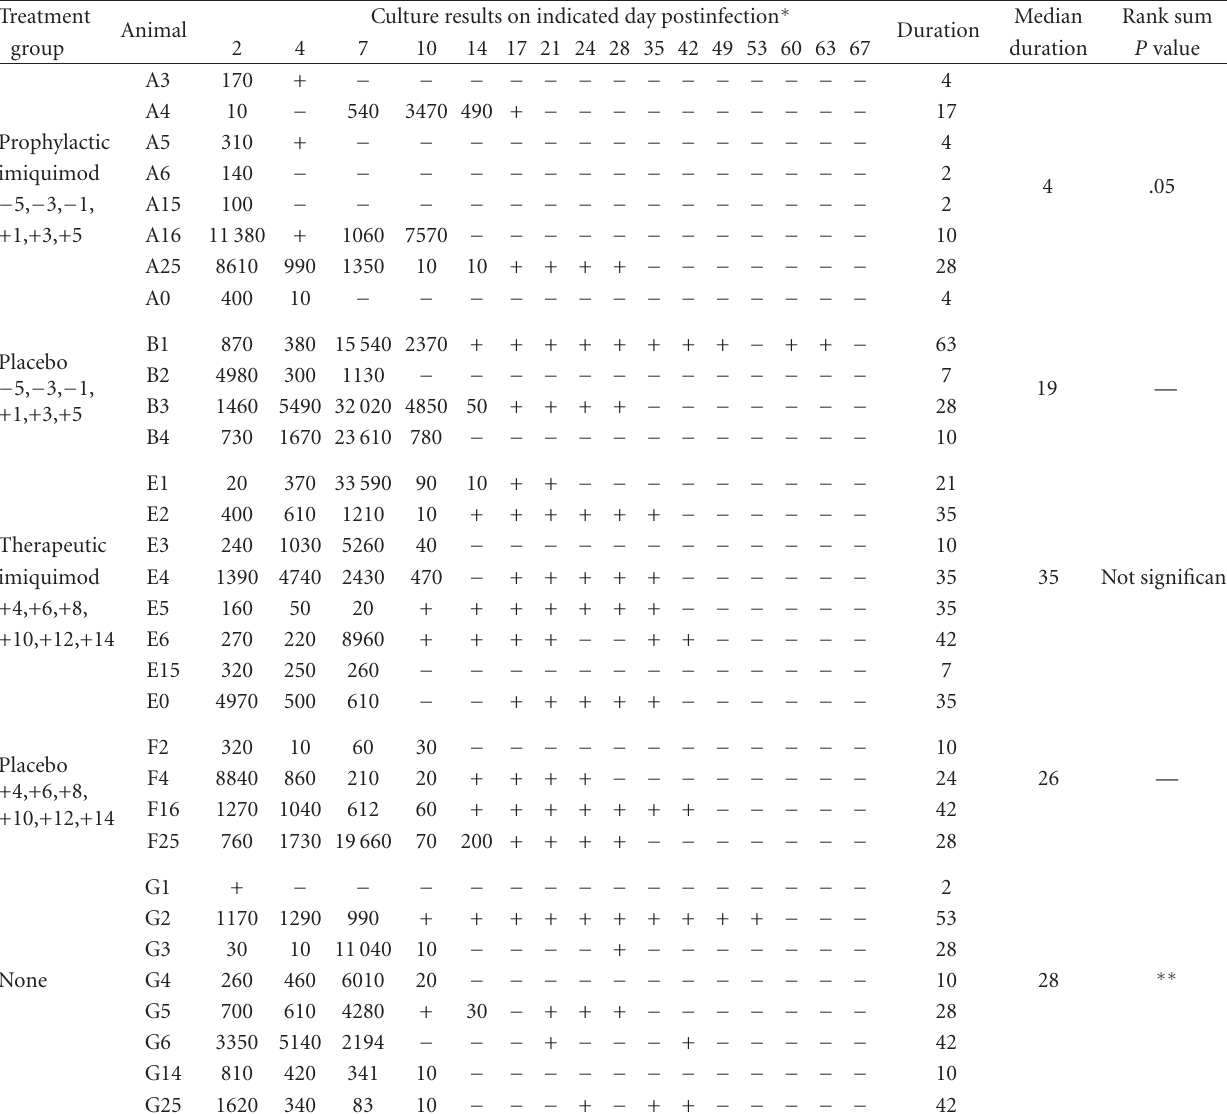
∗ Mice were sampled every 2–7 days postinfection. Numerical values represent the number of IFU enumerated in primary culture through day 14; + / − represents the presence (+) or absence ( − ) of inclusions upon secondary subculture. ∗∗ Not di ff erent from either placebo